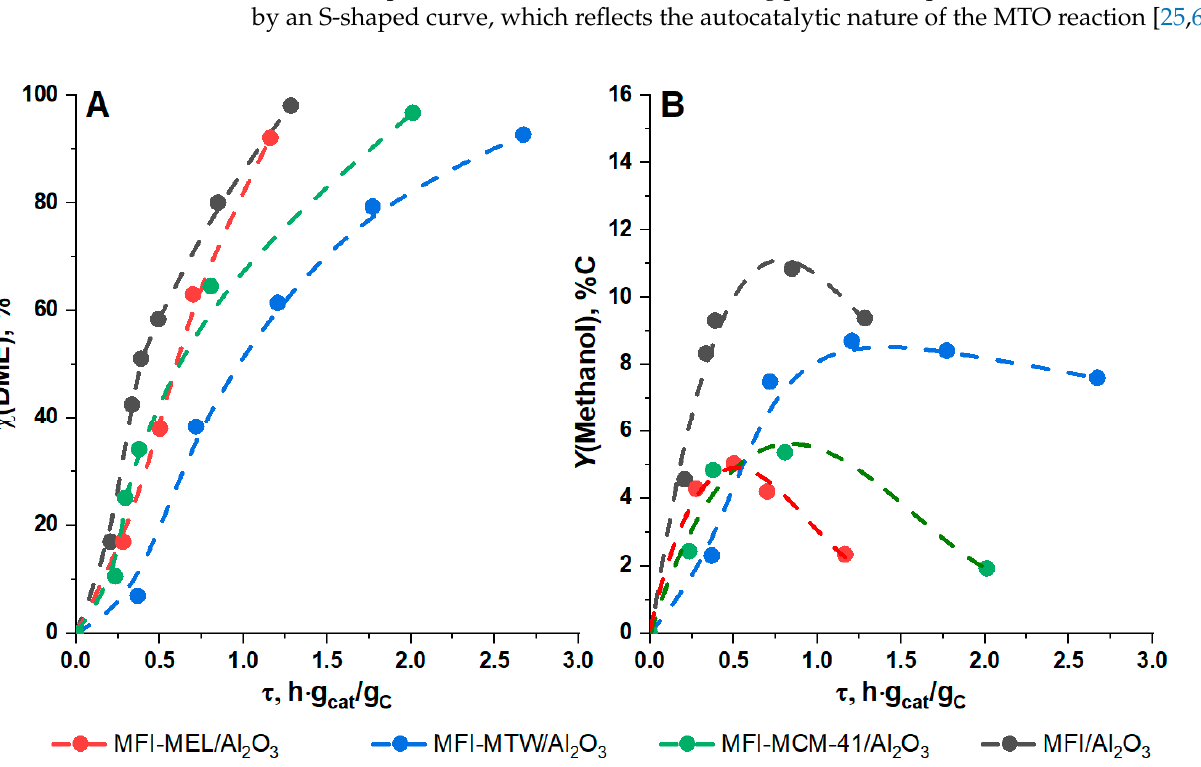
Table 2. Acidic properties of catalysts.